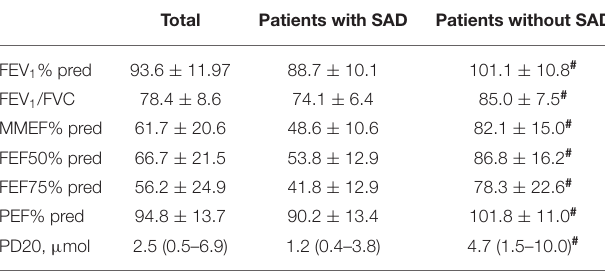
TABLE 2 | Baseline spirometry parameters in patients with SAD and patients without SAD. Total Patients with SAD Patients without